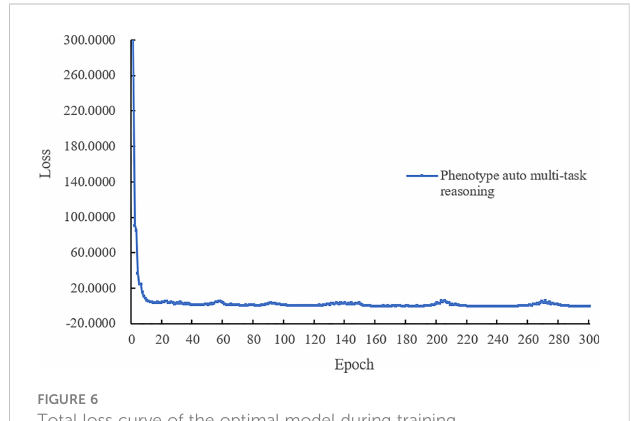
FIGURE 6 Total loss curve of the optimal model during